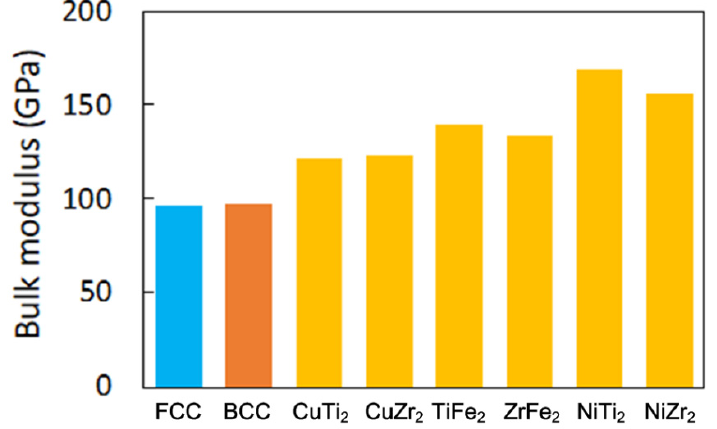
Figure 7. The bulk modulus of the FCC, BCC, and C14 binary Laves phases in the CuFeTiZrNi x al- loy.